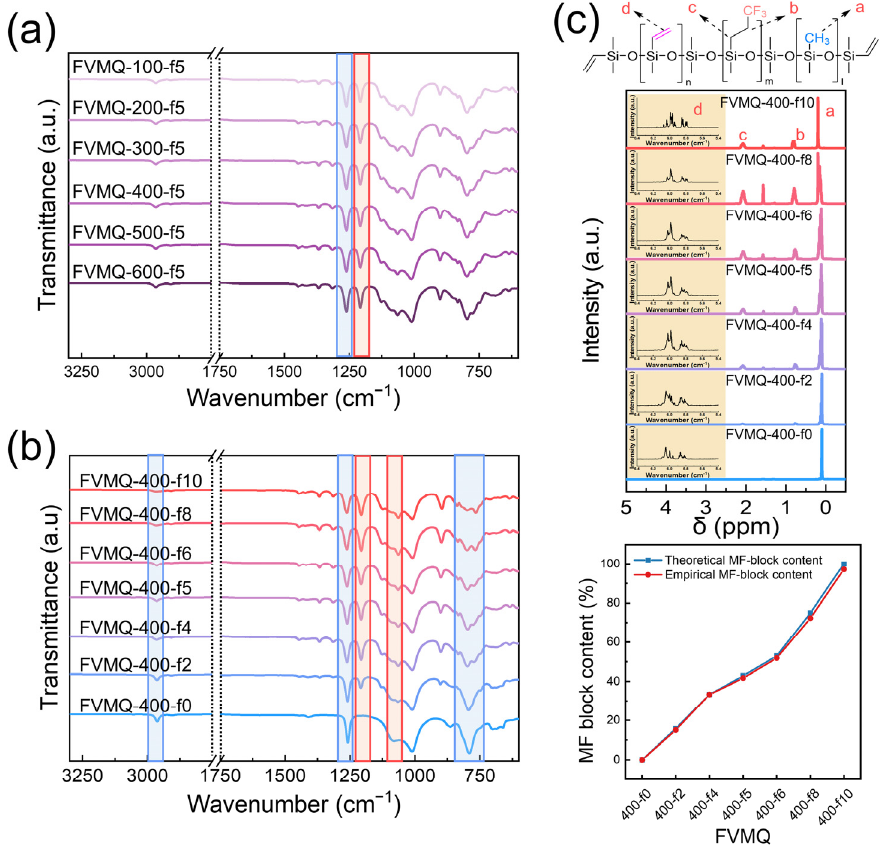
Figure 5. FT-IR spectra of the FVMQs: ( a ) FVMQ-100-f5–FVMQ-600-f5 and ( b ) FVMQ-400-f0 − FVMQ-